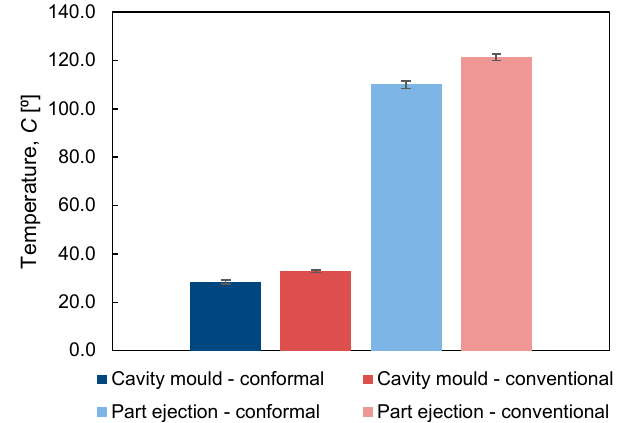
Figure 11. Average temperature measurements with infrared thermal camera immediately after ejection on mould cavity and on part for conformal and convectional cooling.